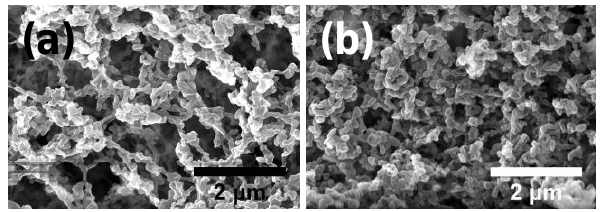
Figure 3. Electron microscopy of ( a ) NC/carbon nanotube (CNT)(sc) and ( b ) NC/CNT/Fe 2 O 3 (sc) .